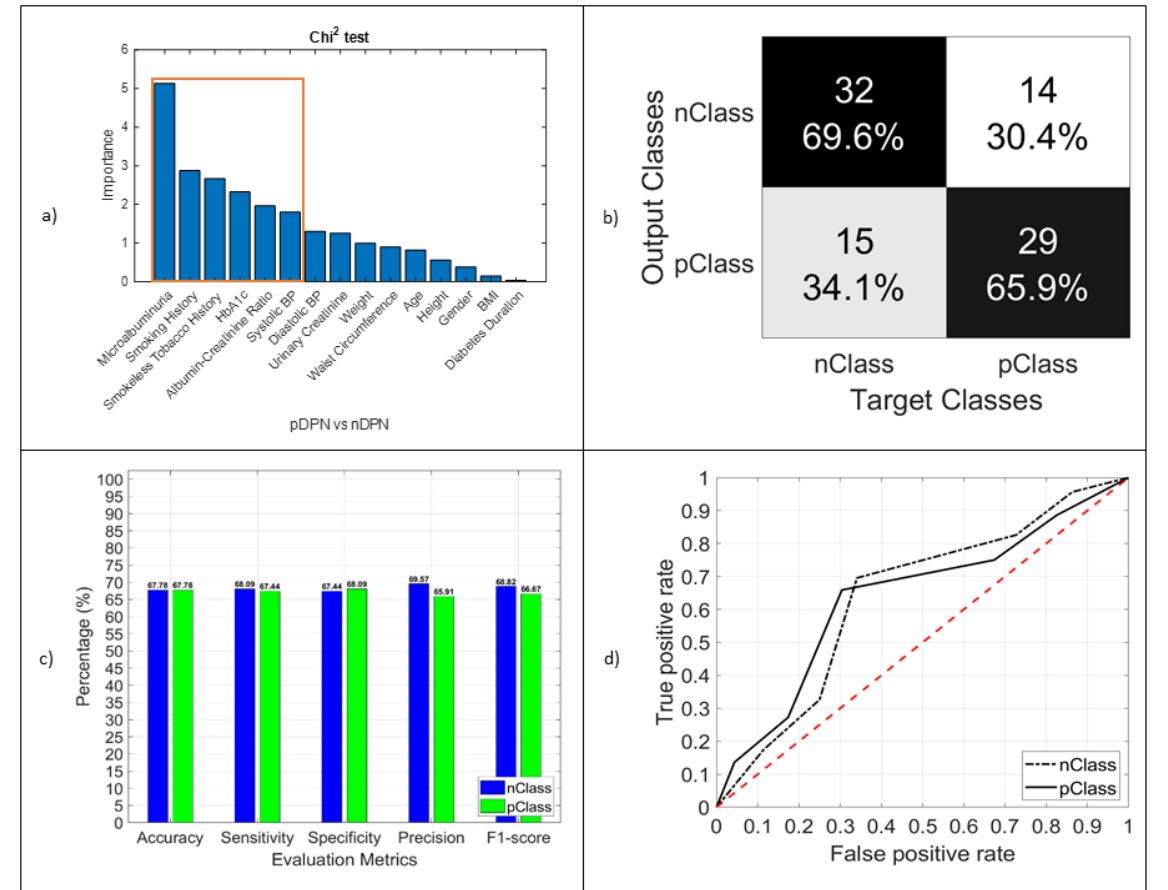
Figure 4. ( a ) Chi-squared test result. The importance of different marked features was used in the model as an identifier; ( b ) confusion matrix of the DPN test (pClass vs. nClass); ( c ) performance evaluation matrices; ( d ) TPR vs. FPR, graphical view of the DPN classifier model performance.